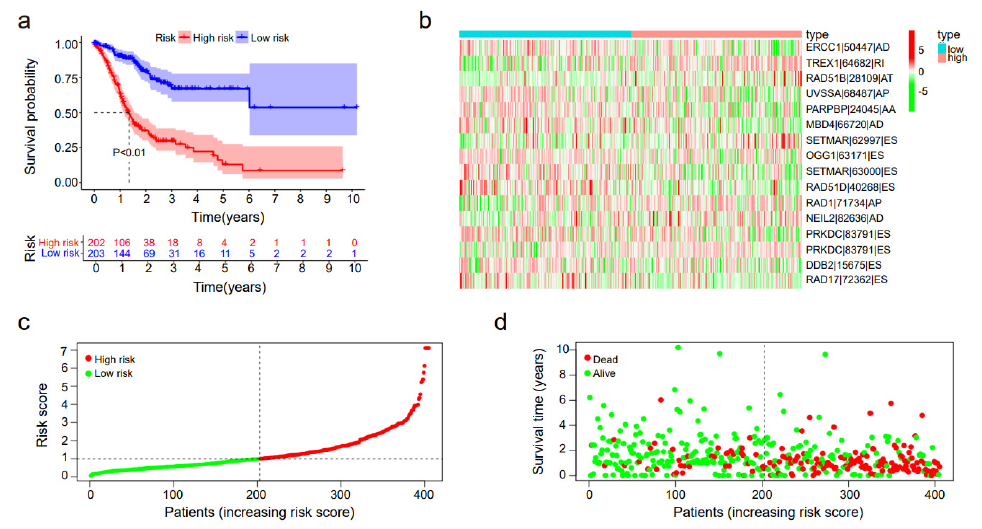
Figure 3. Confirmation of the risk score grounded on important prognosis-related DNA repair genes. ( a ) The Kaplan–Meier plotter of the survival analysis in which low-risk patients (purple curve) are more able to live longer than high-risk patients (red curve). ( b ) The heatmap of the ex- pression of the final 16 selected whole survival-related splicing events from the TCGA dataset. ( c ) Scatter plot performing the risk scores of high-risk group patients and low-risk group patients. The individual inflection points of the risk score curve is shown by the dotted lines. The risk plot of both low-risk patients (green points) and high-risk patients (red points). ( d ) Scatterplot of the survival time and the risk score of both low-risk patients (green points) and high-risk patients (red points). 3.4. Validation of the Risk Score and the Nomogram Grounded on Important Prognosis-Related DNA Repair Alternative Splicing Event Then, the effect of prognostic signatures such as other clinical traits and the risk score in prognosis prediction was assessed by time-dependent ROC (receiver operator charac- teristic) curves. The risk score (AUC = 0.736) had a significantly better survival prediction ability at one year than age (AUC = 0.582), gender (AUC = 0.516), grade (AUC = 0.554), and stage (AUC = 0.609) (Figure 4a). Furthermore, the risk score had a better prediction ability at 2 years (AUC = 0.770) than at 1 year (AUC = 0.736) and 3 years (AUC = 0.747) (Figure 4b).